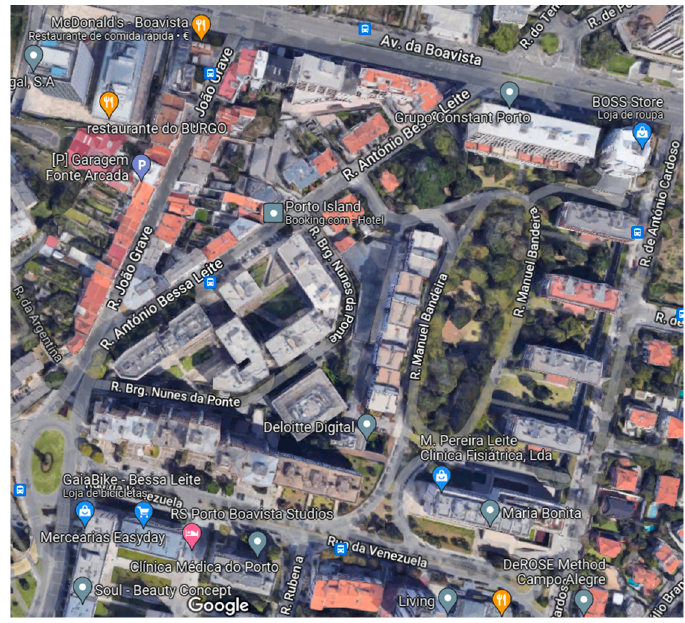
Figure 3. Aerial view of the chosen urban area—Boavista Neighborhood—Porto, Portugal.